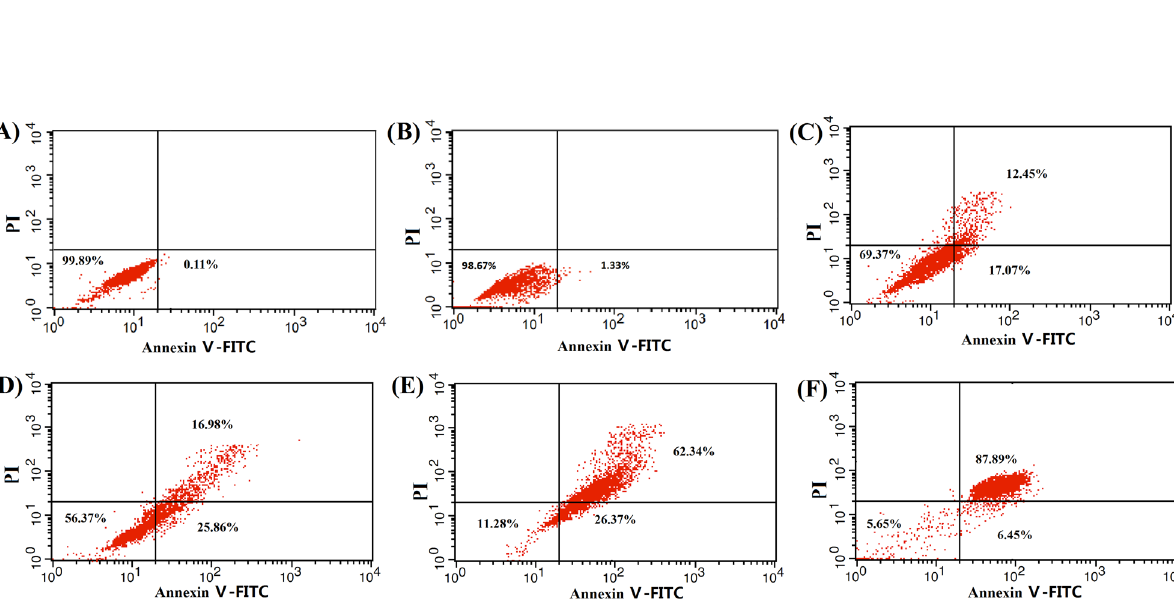
Table 1. Physicochemical characterization of DOX-loaded polymeric mixed micelles (n = 3).